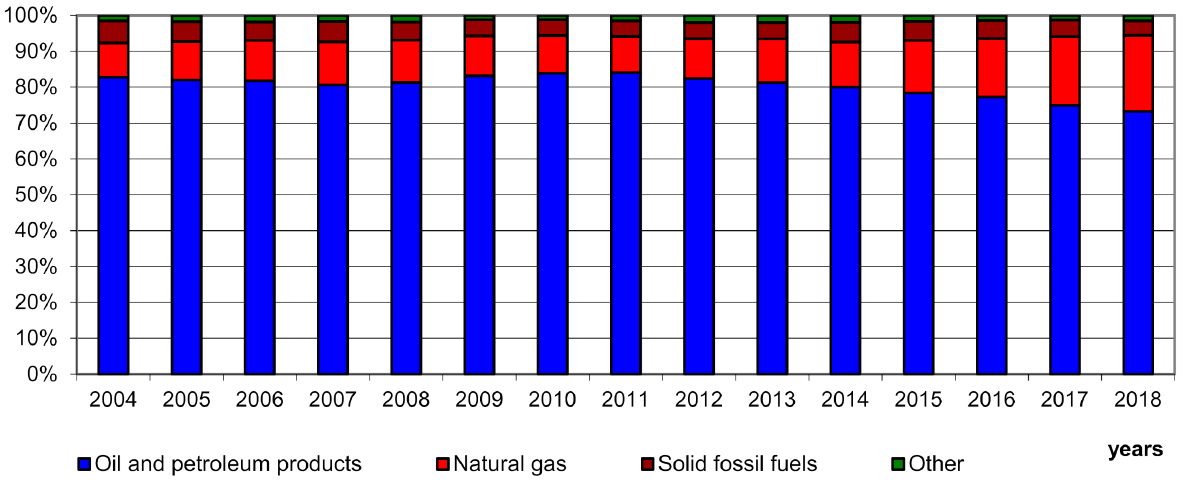
Figure 5. Share of energy import sources in Netherlands in